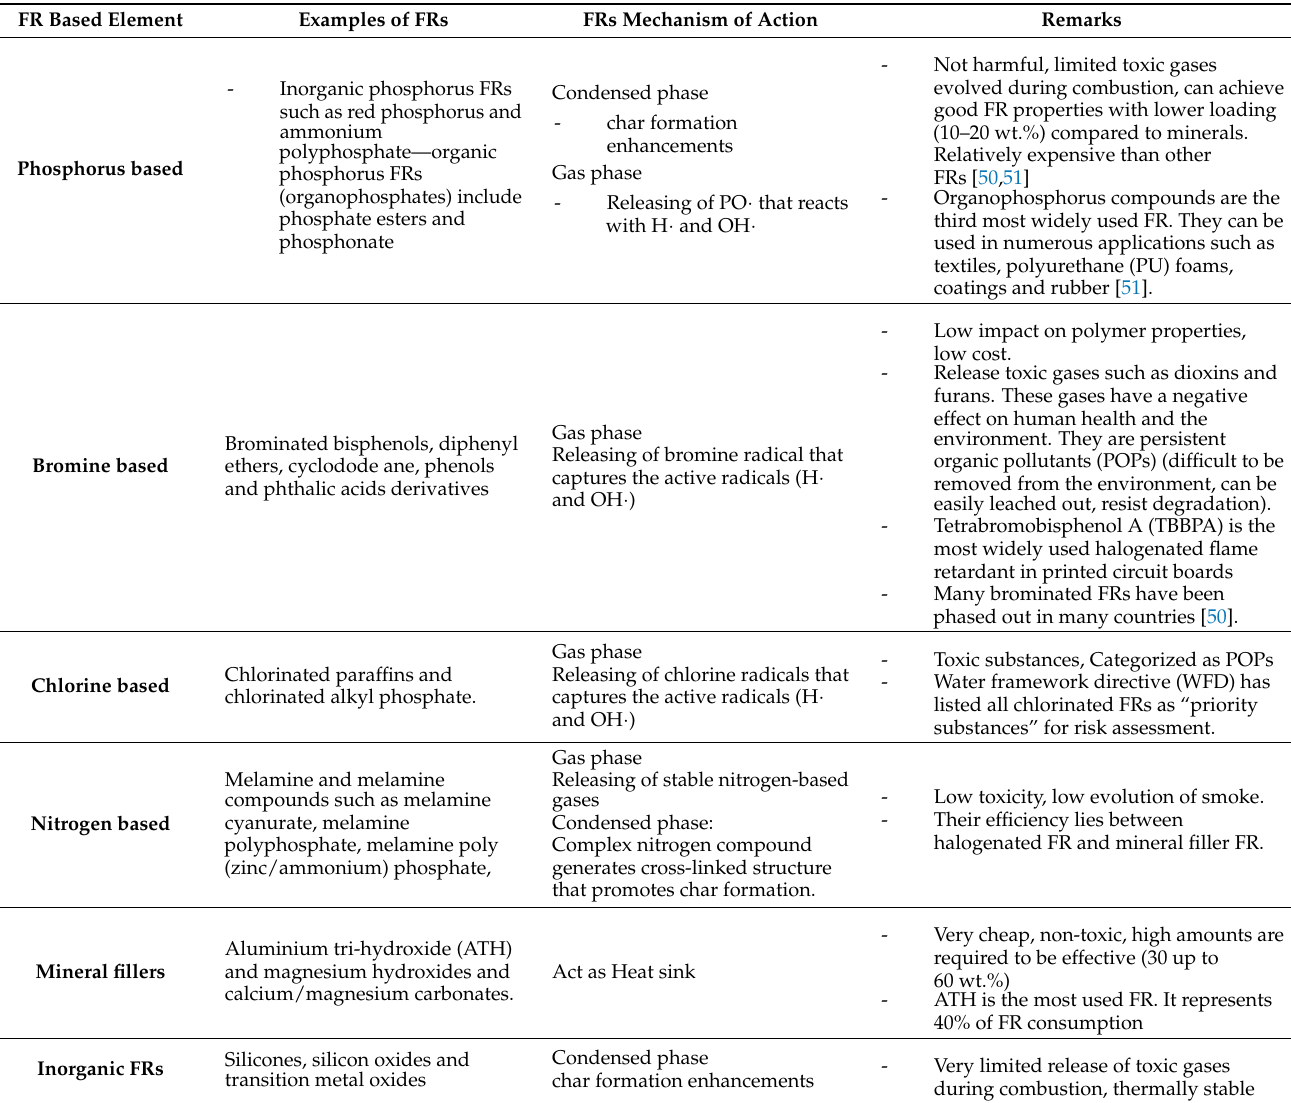
Table 3. Examples of FRs and their mechanism of